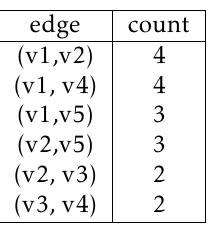
Table 5. Frequent Edges with count for Batch 1 and Batch 2